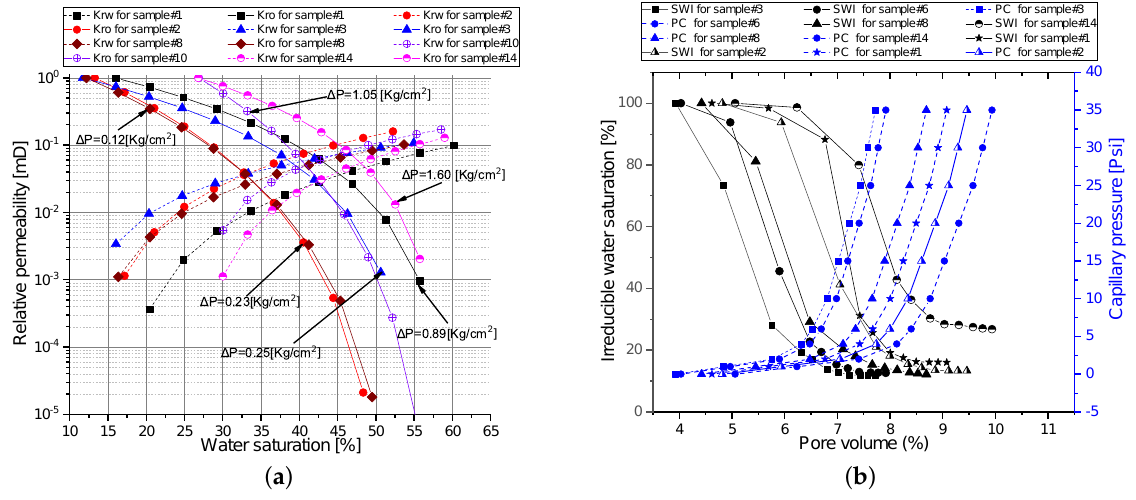
Figure 9. Relative permeability versus water saturation highlighting ( a ) the injection pressure effect on the relative permeability and ( b ) irreducible water saturation and capillary pressure versus pore volume for the study rocks in this section.